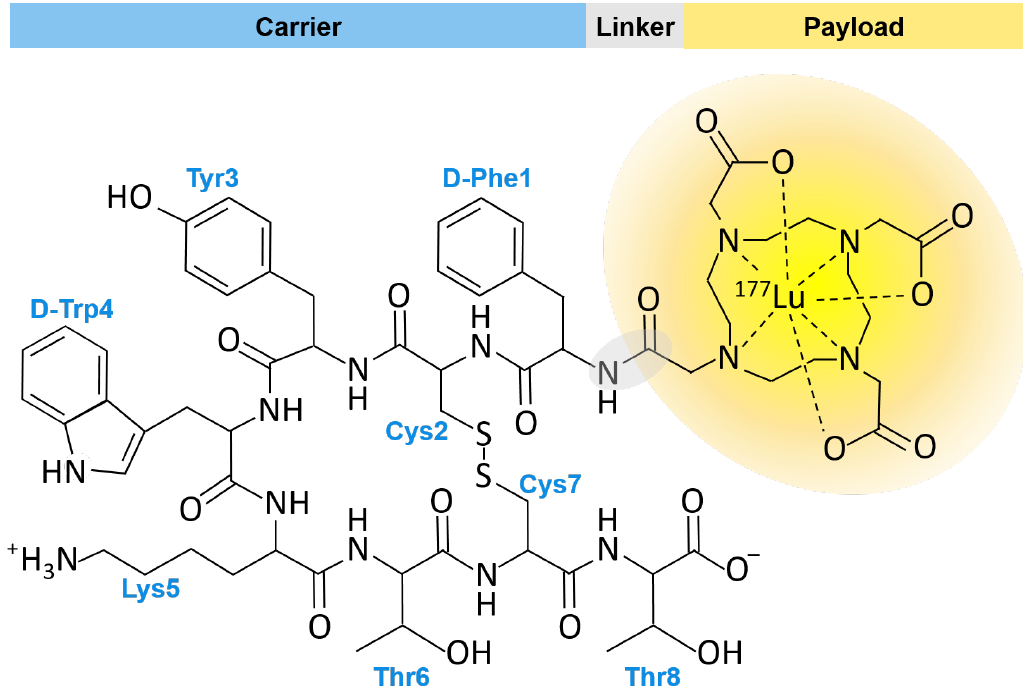
Figure 2. Structure of 177 Lu-DOTA-TATE (Lutathera ® Novartis, Zaragoza Spain). Amino acid residues of the carrier peptide, the tyrosine-containing somatostatin analog Tyr3-octreotate (TATE), are labeled in blue. The payload (highlighted in yellow) is the macrocyclic chelating agent tetraazacyclododecane-tetraacetic acid (DOTA) bound to the beta-emitting radionuclide lutetium-177 ( 177 Lu). The linker region (highlighted in grey) consists of an amide bond formed by coupling a carboxyl group of DOTA with the N-terminal amino group of the carrier at D-Phe1.